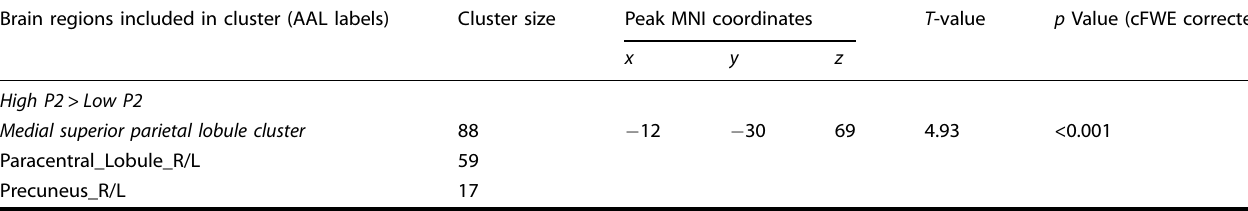
Table 4. Brain regions showing reduced centrality in the high P2 group ( n = 12) compared to the low P2 group ( n = 26). Brain regions included in cluster (AAL